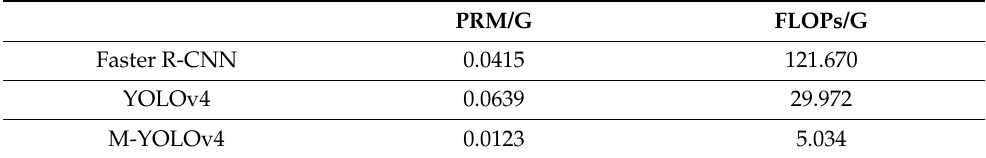
Table 3. Comparison of PRM and